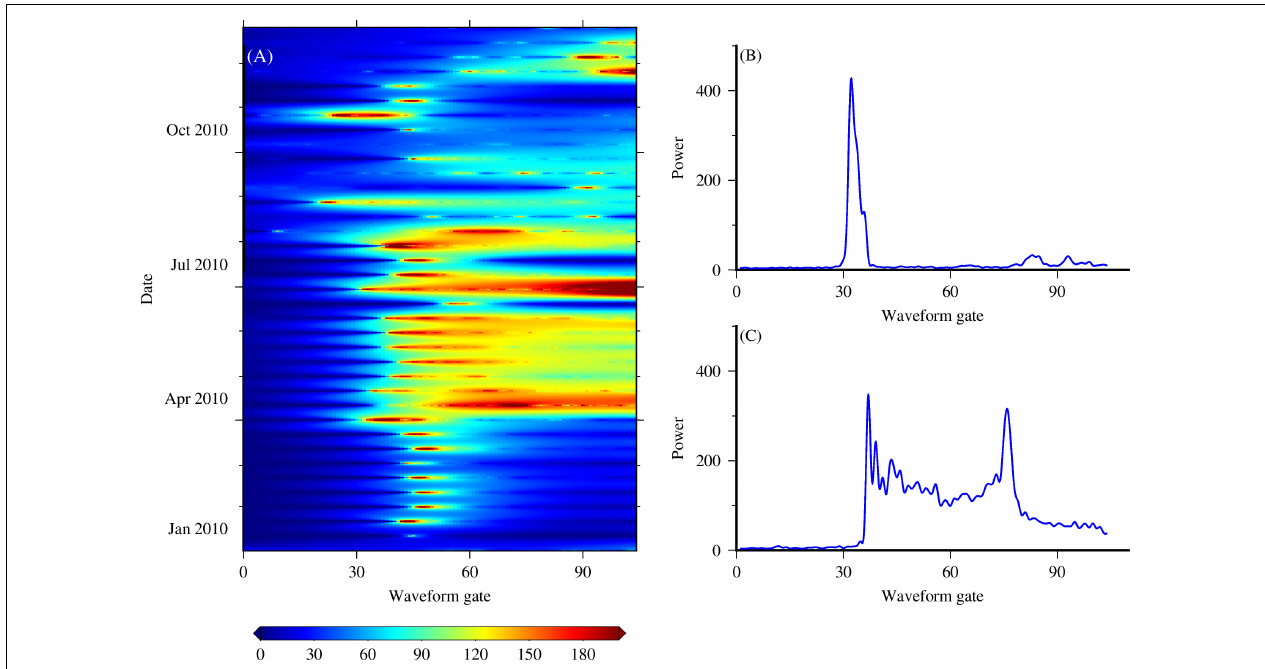
FIGURE 4 | Waveform of Jason-2 altimeter in 2010. (A) The annual waveform. (B) Typical winter waveform. (C) Typical summer waveform.